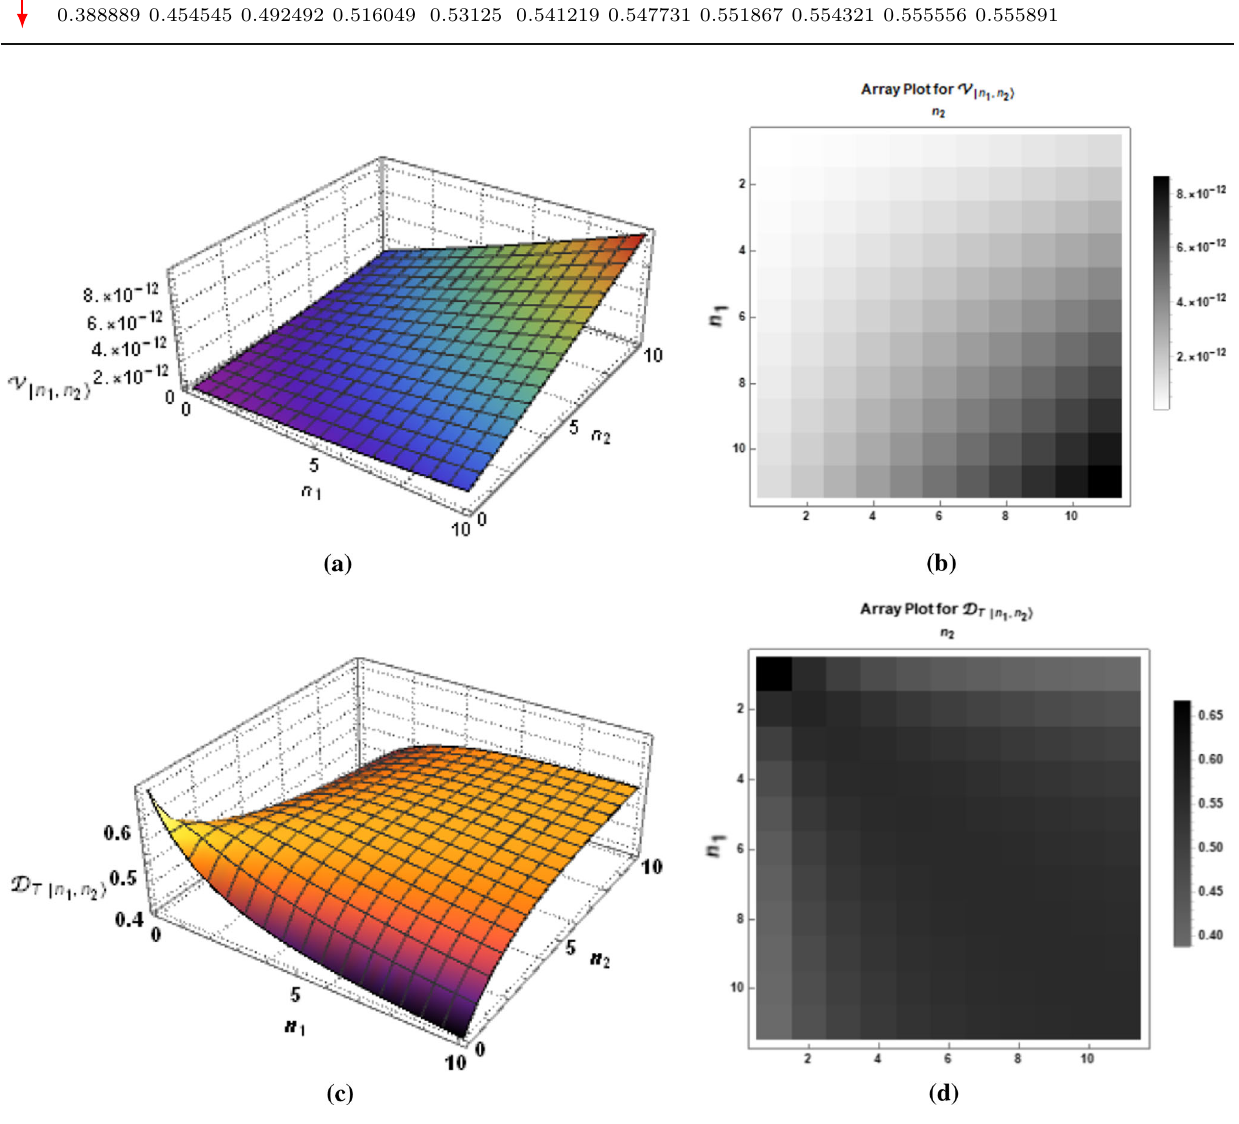
Fig. 2 a , b Shows density fluctuations V T | as a function of n 1 and n 2 particles states. Here, b is an array plot for the same range and choices of parameters as in a . Similarly, behaviour